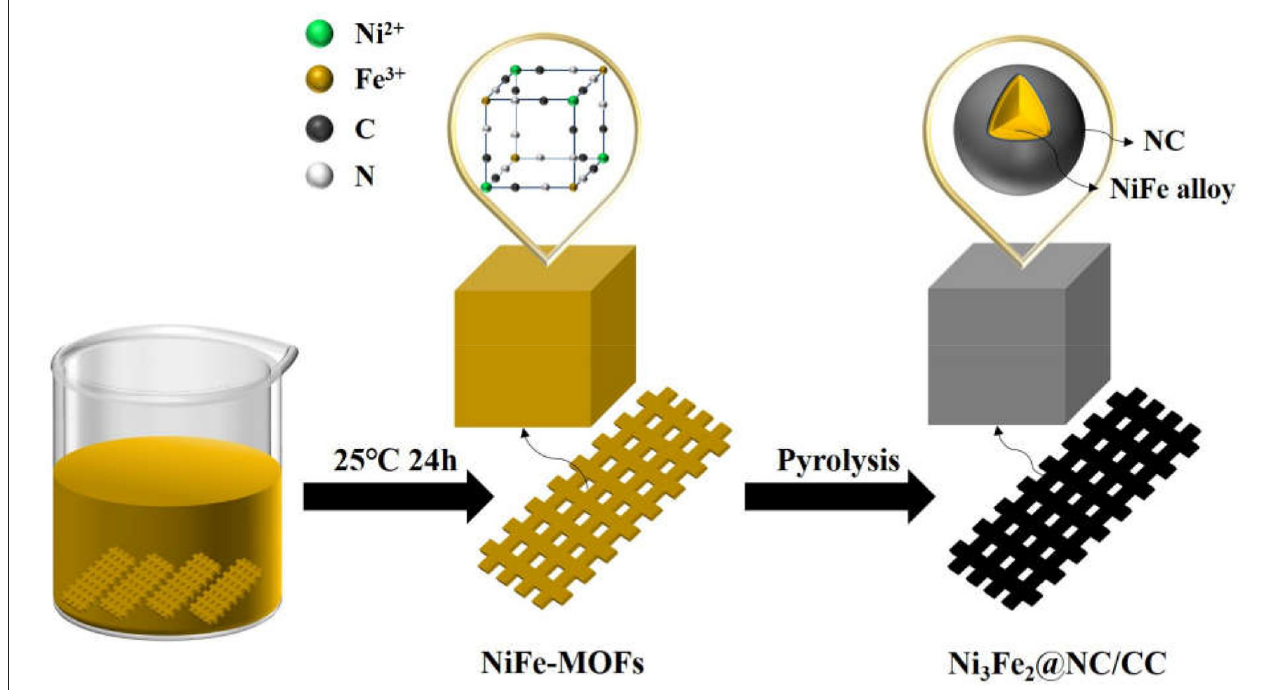
FIGURE 1 | Illustration of the preparation procedures of Ni 3 Fe 2